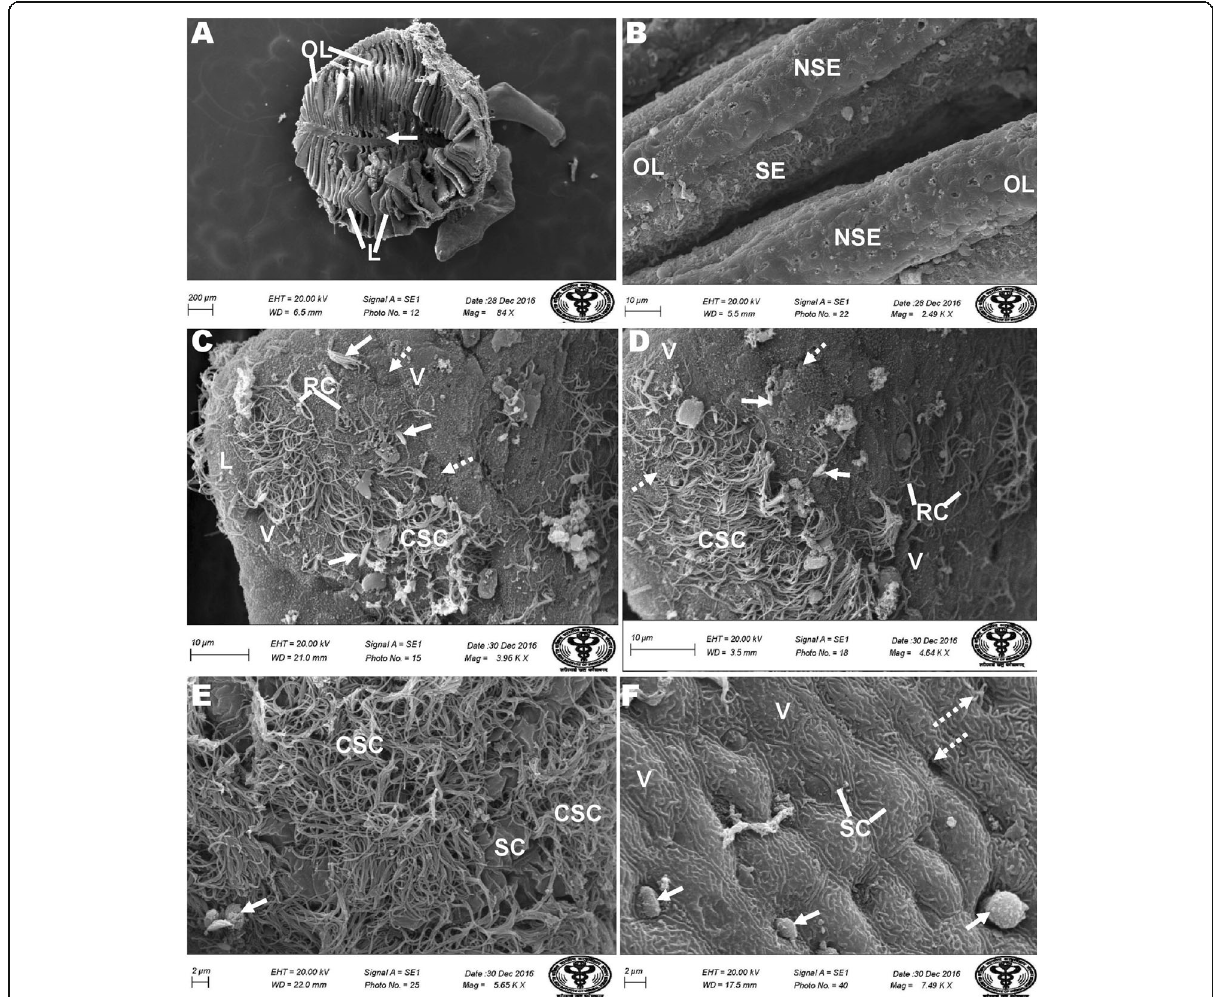
Fig. 4 Photomicrographs of the topological view of olfactory epithelia of E. vacha by scanning electron microscopy (SEM). A Dorsal view of gross olfactory rosette furnishes olfactory lamellae (OL) with linguiform processes (L) emitted from raphe (arrow). B Alignment of sensory (SE) and nonsensory (NSE) epithelium on OL. C Sensory islet of linguiform process (L) shows dendrite tips of ciliated receptor cells (RC), rod cells (RD) (solid arrows), and microvillous cells (arrow heads). Note the presence of ciliated supporting cells (CSC) and labyrinth cells (LC) (broken arrows). D Lateral surface of lamella shows sensory epithelium with RC, rod cells (solid arrows), and microvillous cells (arrow heads), and nonsensory epithelium contains CSC and labyrinth cells (broken arrows). E Surface of nonsensory mucosa illustrates dense aggregation of ciliated supporting cells (CSC) and nonciliated supporting cells (SC). Arrow marks mucin masses. F Close up view of raphe exhibits SC with conspicuous microridges (arrow heads) and elevated mucous cell (broken arrows). Note the presence mucin balls (solid arrows) over